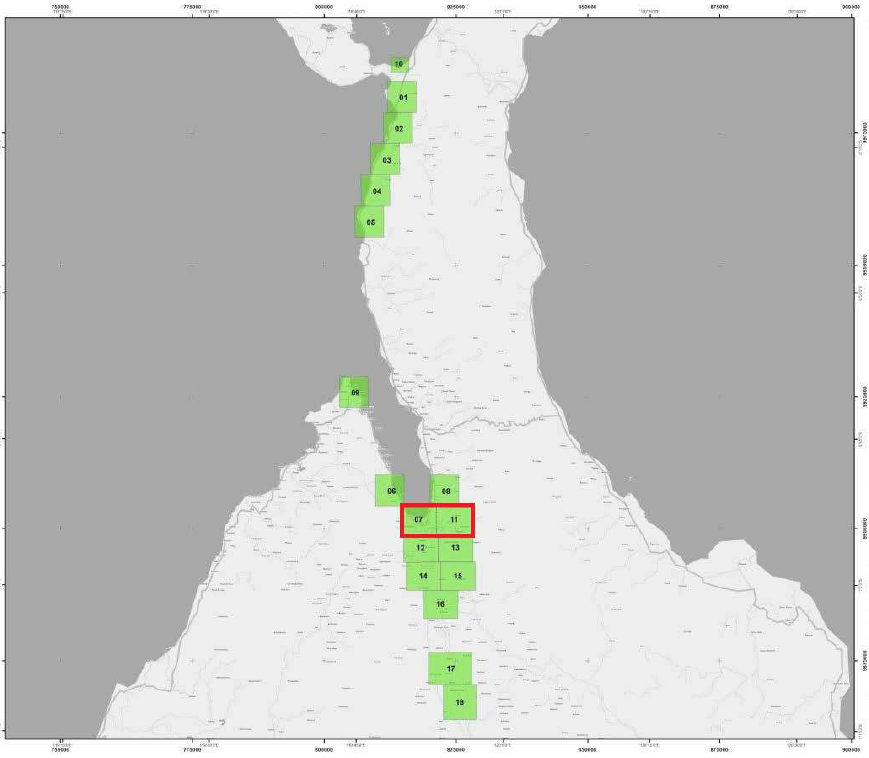
Figure 1. Areas of Interest of the earthquake and tsunami,